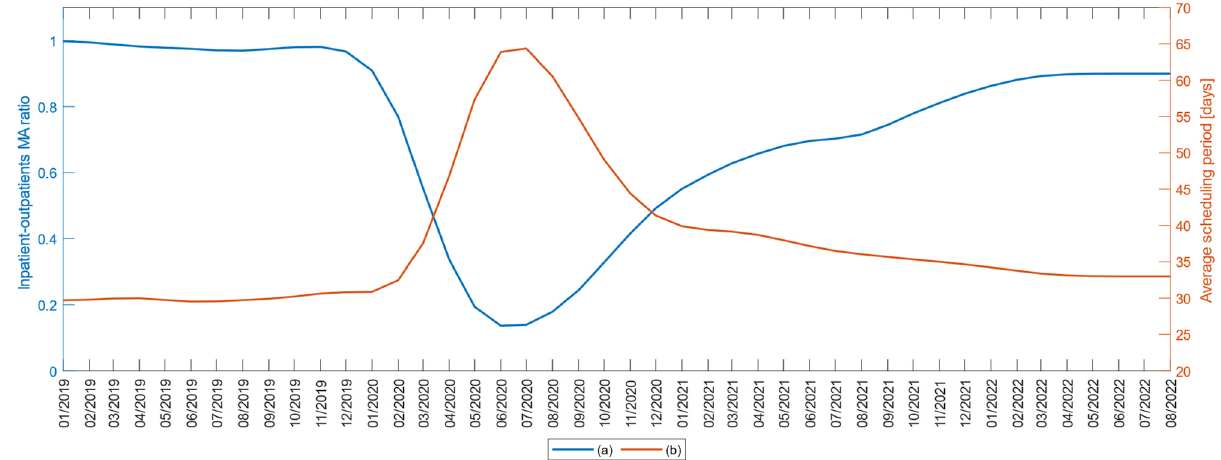
Figure 4. ( a ) The three-month moving average of the ratio of inpatients to outpatient patients; ( b ) The three-month moving average of the average length of hospital programming.